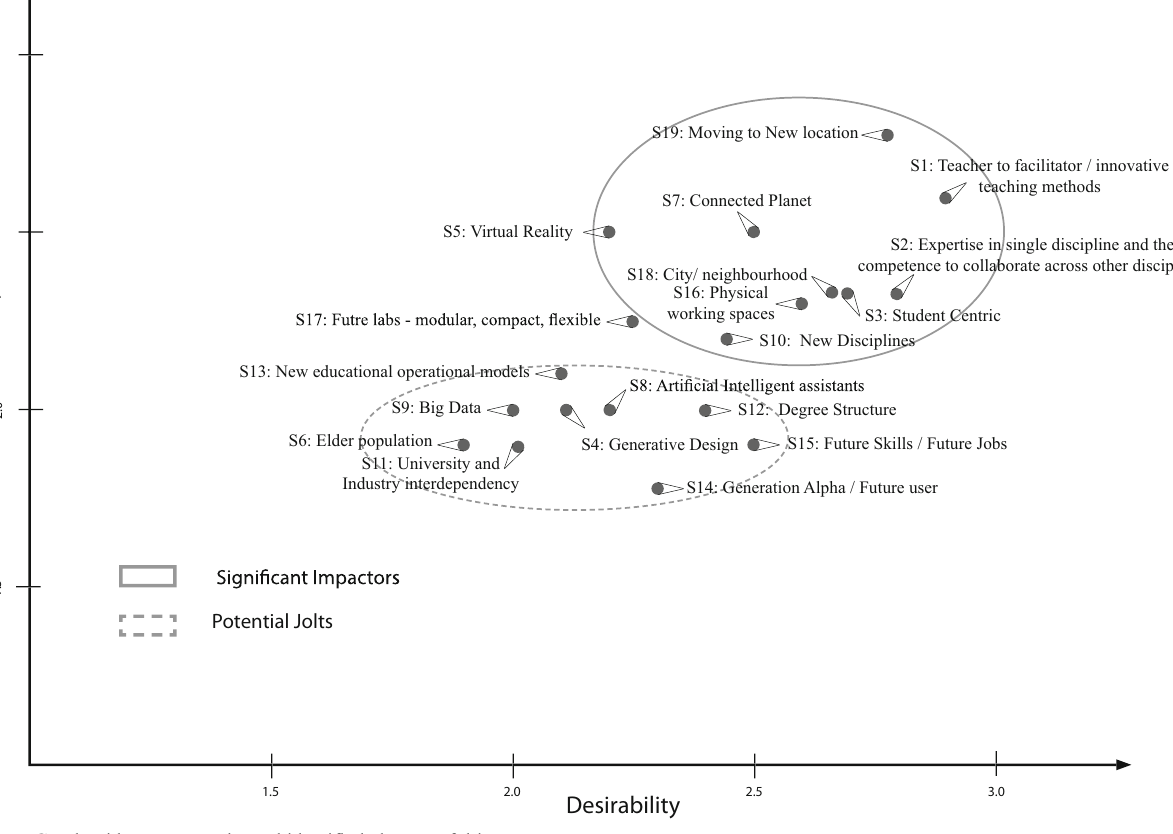
Fig. 4 Graph with survey results and identified clusters of